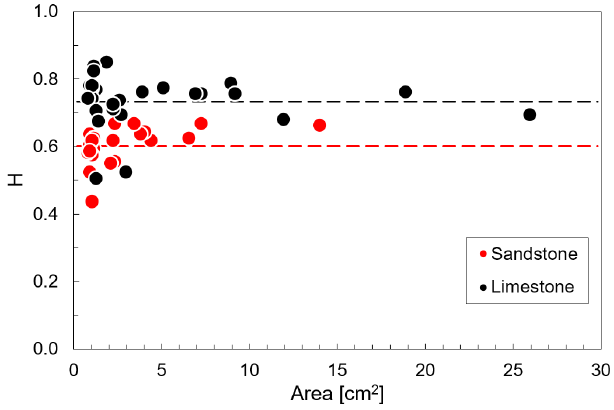
Figure 14. Calculated Hurst exponent for different sizes of the mea- surement area in the natural rock samples. Circles: individual mea- surements, dashed lines: average of all measurements per